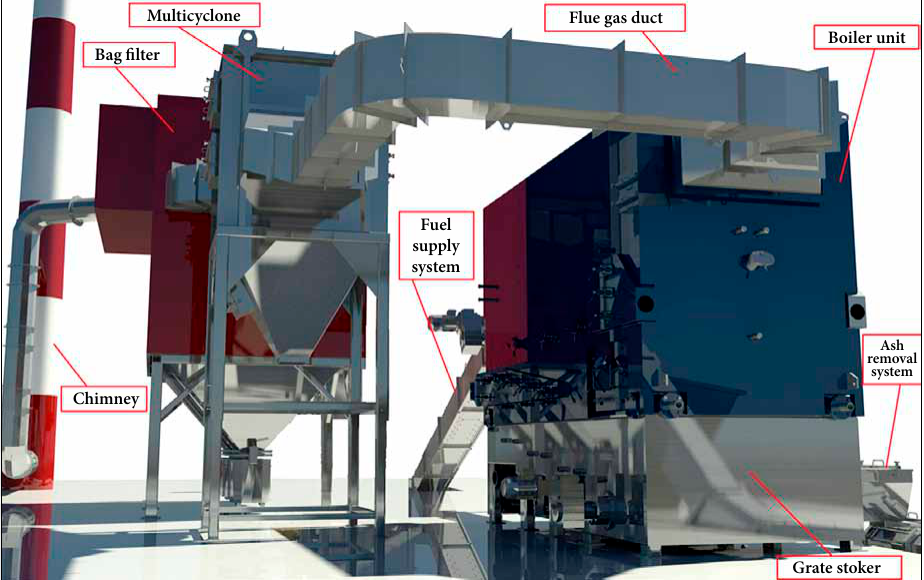
Fig. 1. The scheme of pilot boiler house installation intended for different kinds of solid